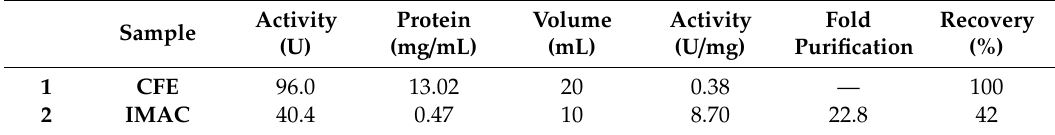
Table 1. Summary of recombinant KGUK cnec purification (from 20 mL of cell-free extract